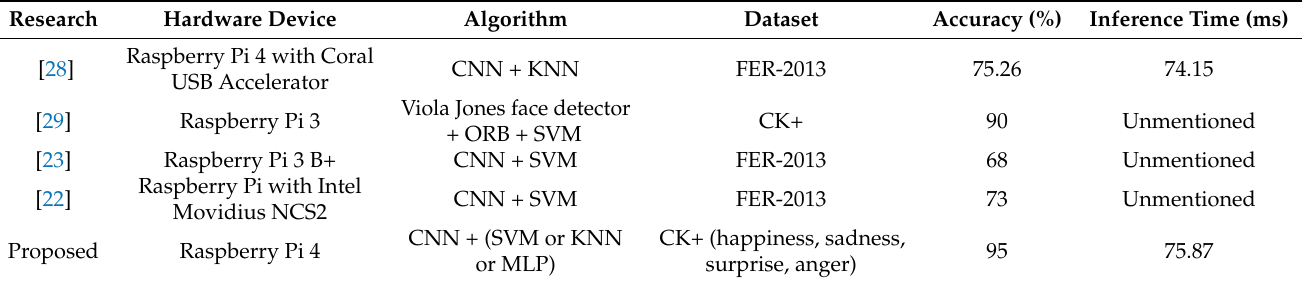
Table 18. Comparison of the proposed system with previous